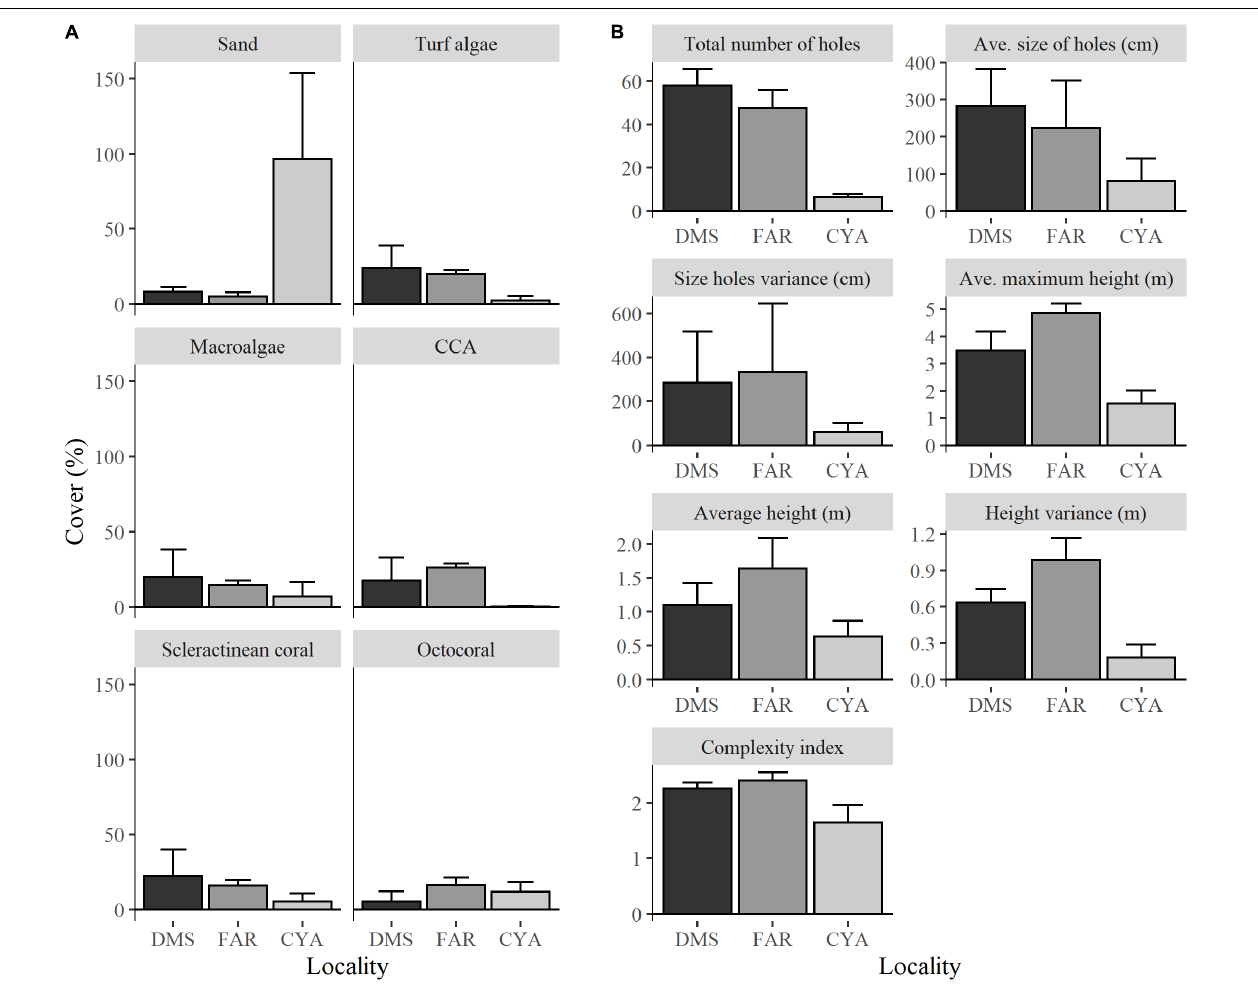
FIGURE 3 | Average percent cover for benthic habitat (A) and proxies of structural complexity (B) at each site. Error bars represent standard